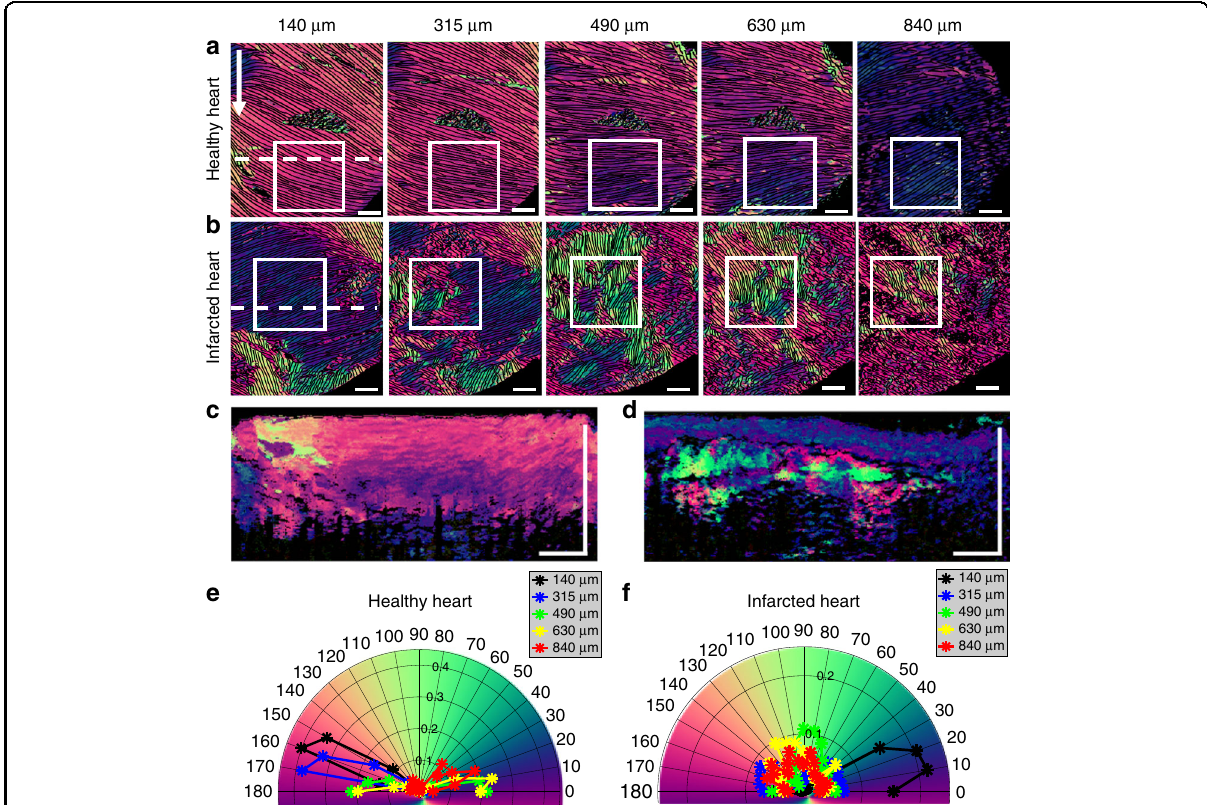
Fig. 2 Depth-resolved myo fi ber organizations in healthy and infarcted rat hearts. With the proposed DDG-based PST method, single input PSOCT is capable of imaging the depth-resolved myo fi ber disorganization in infarct rat hearts. Results shown were obtained from healthy and infarcted hearts, respectively. The en-face local axis orientation (OAx) images of a the healthy rat heart b the infarct heart at different depths as shown from 140 μ m to 840 μ m. Cross-sectional axis orientation images of c the healthy rat heart d the infarct heart at the regions indicated by the white dash lines in a and b . e, f The polar histogram distributions of orientation obtained from the white boxes in the healthy heart a and the infarct heart b at fi ve depths relative to the tissue surface (140 μ m, 315 μ m, 490 μ m, 630 μ m and 840 μ m), respectively. White arrow at the top left points to the apex. The yellow arrow indicates the B-scan direction, which is de fi ned as the 0°. Note that a triangular black tape was used as the guide to align the system scanning during imaging, which appears as an artifact in the middle of images in a . The scale bar = 1